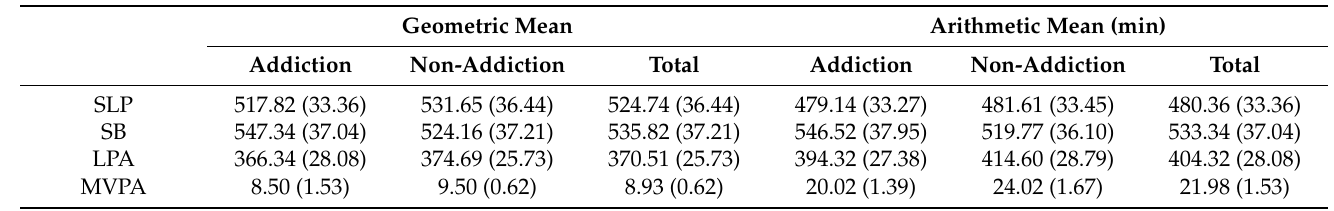
Table 2. The 24-Hour movement behavior’s central tendency of the participants in minute/day (% of 24 h).